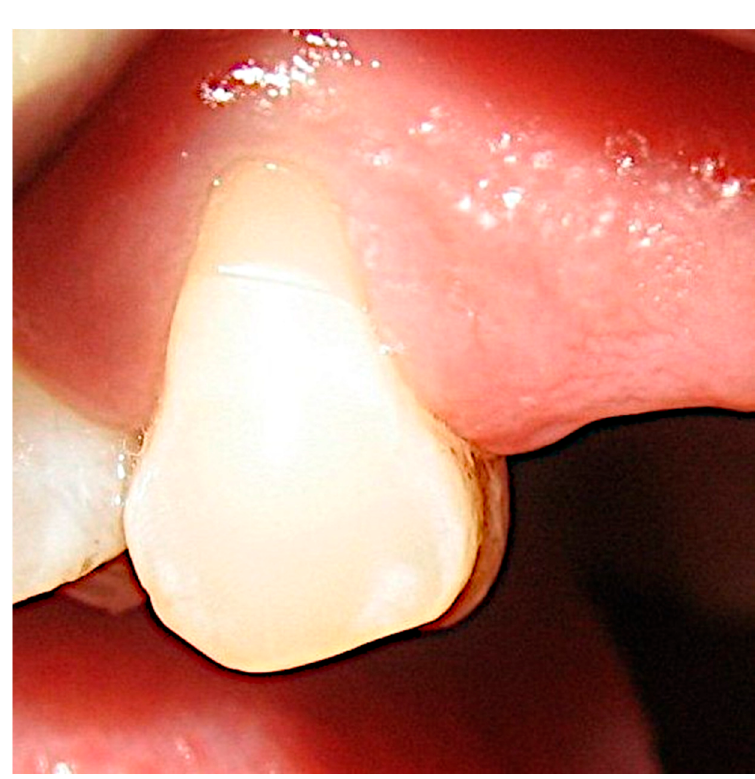
Figure 3. Selection of the most sensitive tooth in the oral cavity.